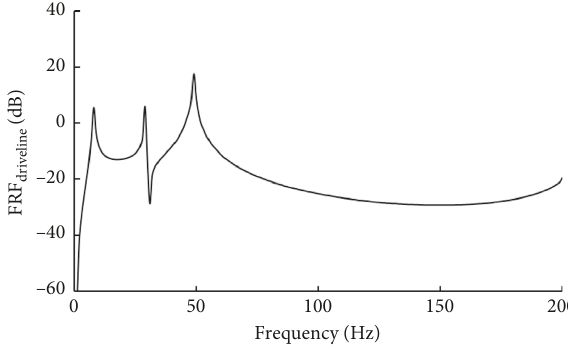
Figure 24: Frequency response function of driveline.